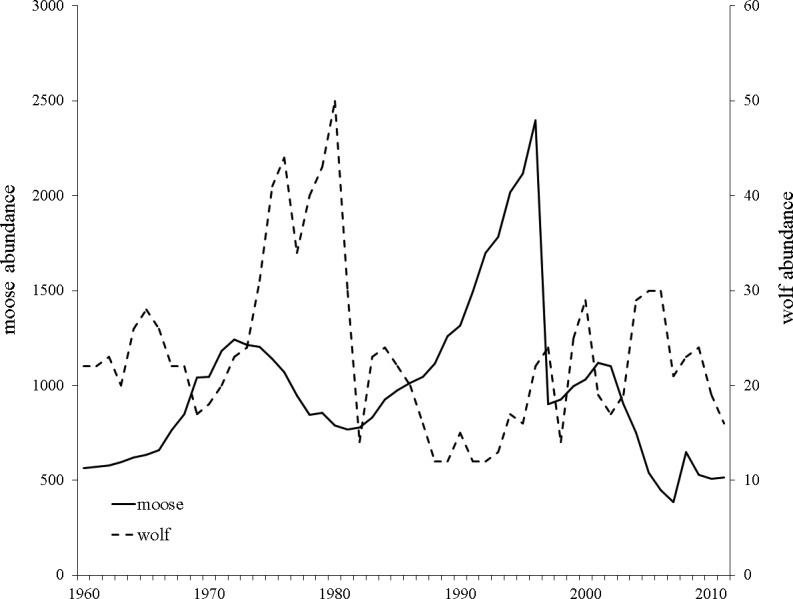
Yearly Isle Royale moose (Alces alces) and wolf (Canis lupus) population census size since 1959.Moose population size is presented with a solid black line and wolf population size with a dashed black line. Data obtained from http://www.isleroyaleowolf.org (Vucetich & Peterson, 2012).